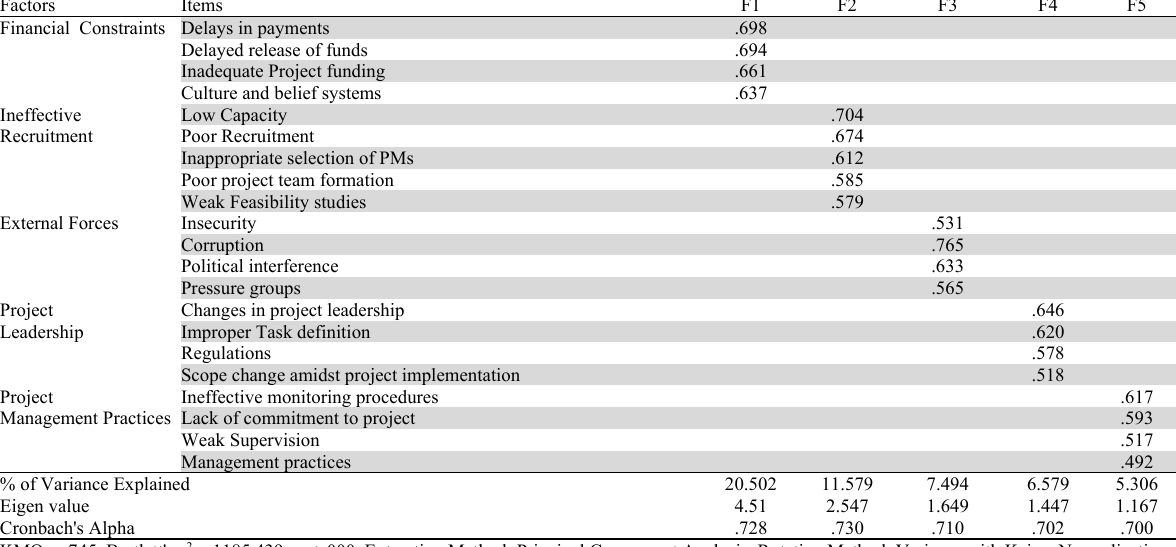
Results of Exploratory Factor Analysis for Failure Factors (N =